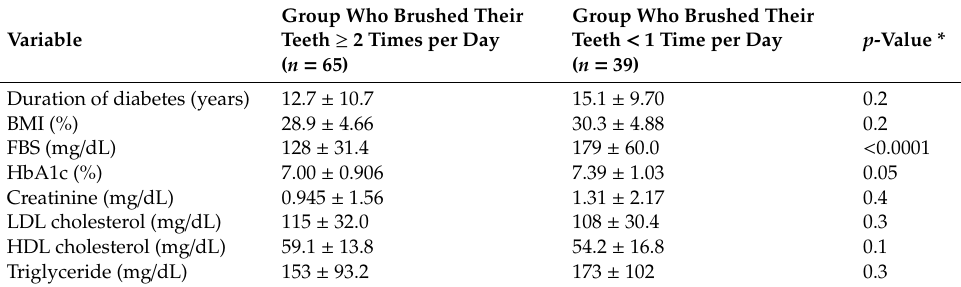
Table 3. Characteristics of the groups who brushed their teeth < 1 and ≥ 2 times per day.